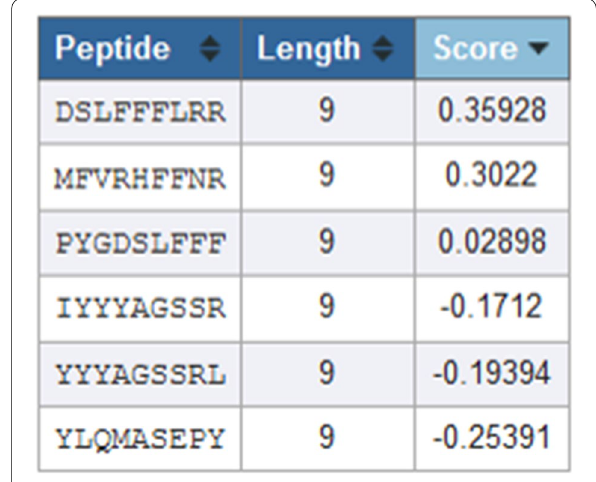
Fig. 15 Immunogenicity of six T cell